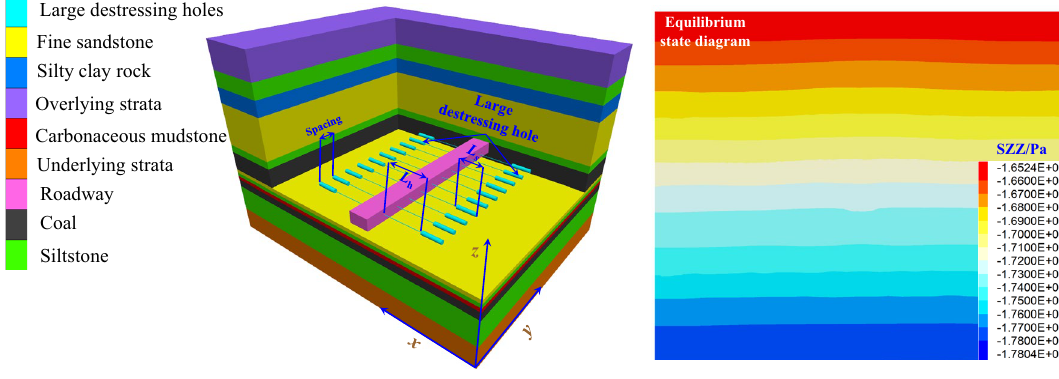
Figure 7. Numerical calculation